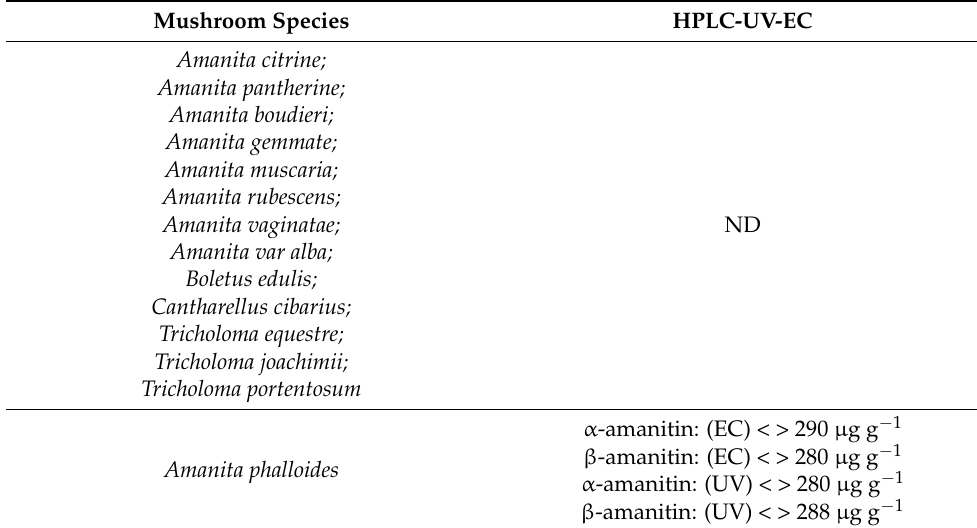
Table 5. Amanitin identification and quantification in Portuguese wild mushrooms.